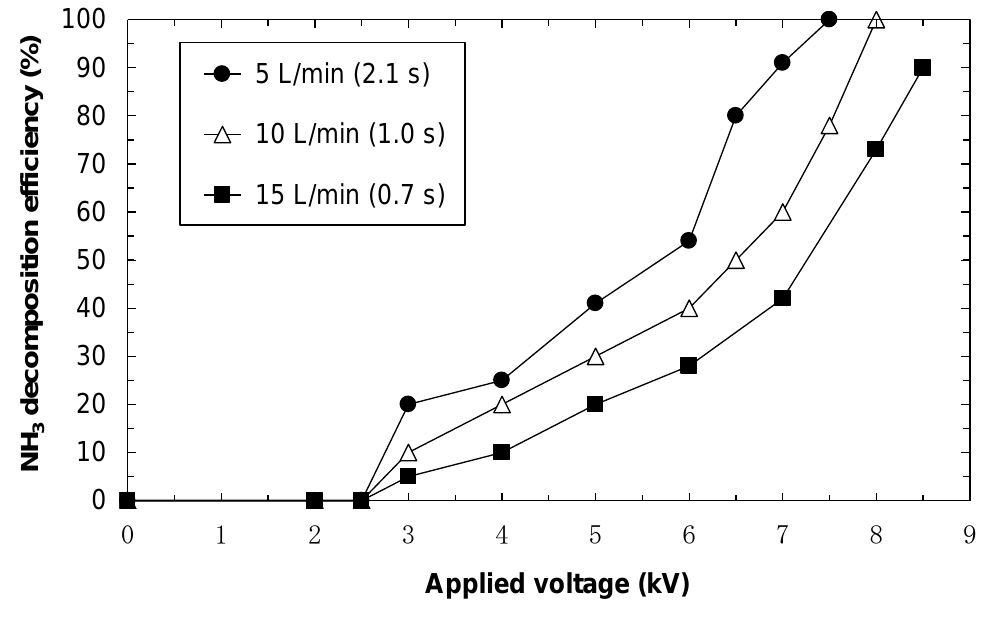
Figure 8. Effect of flow rate ammonia decomposition (initial concentration = 100 ppm, laminated film-electrode plasma